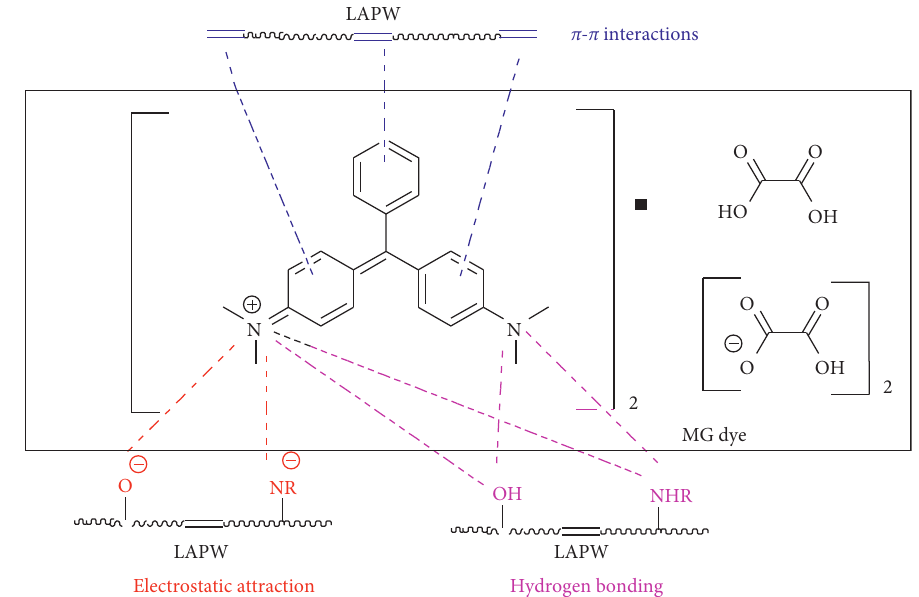
Figure 15: Possible adsorption mechanisms between LAPW and MG dye. Table 6: Previously reported adsorption capacities of various wastes for MG dye